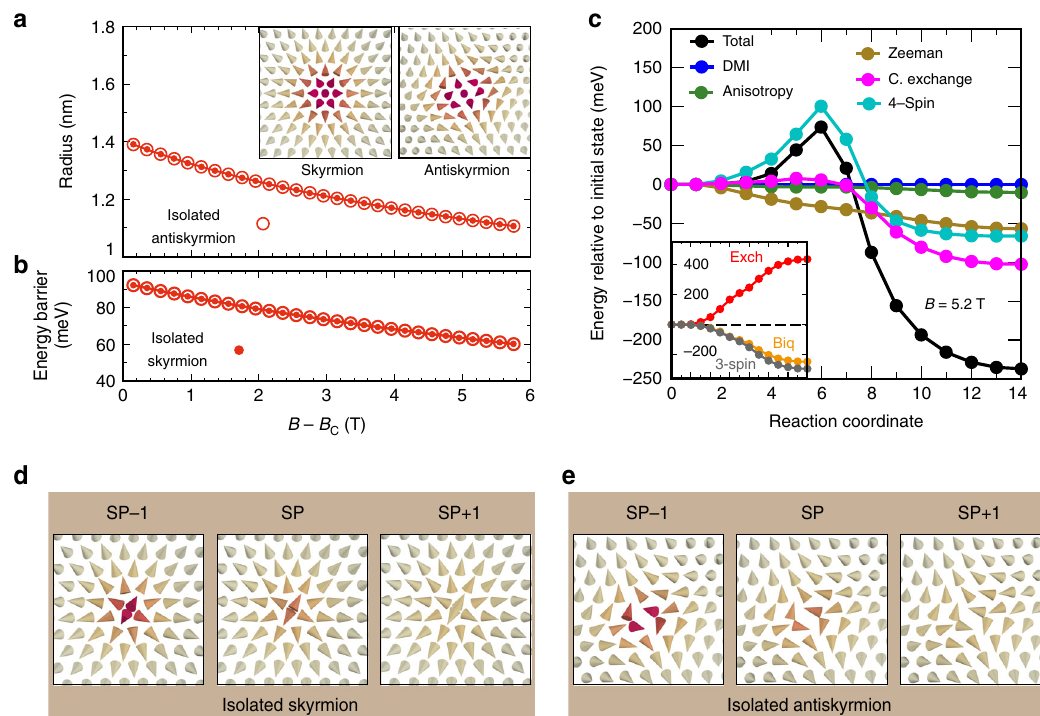
Fig. 6 Skyrmions and antiskyrmions in Pd/Fe/Rh(111) stabilized by HOI at zero DMI. a Radius of isolated skyrmions and antiskyrmions as a function of the external magnetic fi eld. The DMI constants from the DFT calculations for Pd/Fe/Rh(111) have been set to zero for these atomistic spin simulations. Insets show the skyrmion and antiskyrmion state at B = 5.2 T. B c is taken from Fig. 2b. b Energy barriers preventing skyrmion and antiskyrmion collapse. c Energy along the minimum energy path for skyrmion/antiskyrmion collapse at a fi eld of B = 5.2 T (black curve and circles). The energy is decomposed into the contributions from the magnetocrystalline anisotropy, the Zeeman energy, the combined exchange, i.e., the contributions shown in the inset, and the four-site four spin (4-spin) interaction. d , e Spin con fi gurations of the images before (SP-1), at (SP), and after (SP + 1) the saddle point (SP) for the minimum energy path at B = 5.2